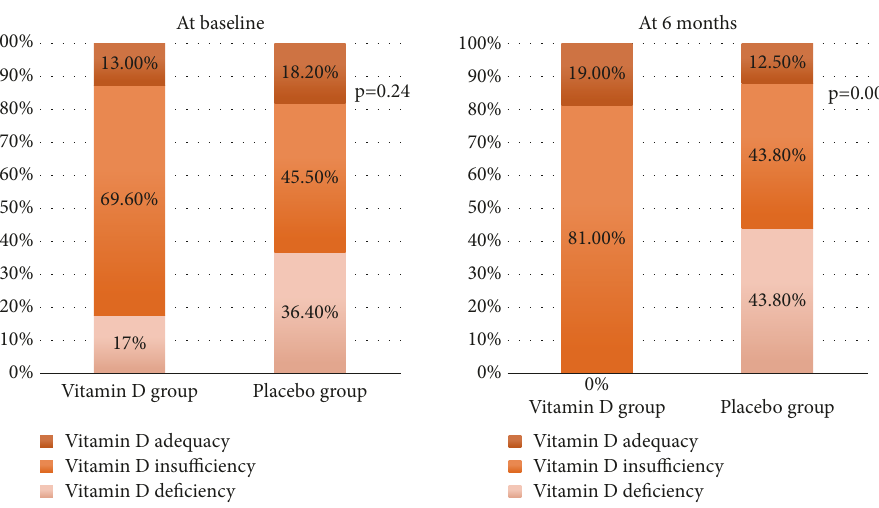
Figure 4: Vitamin D status in each group at baseline and the 6-month follow-up.